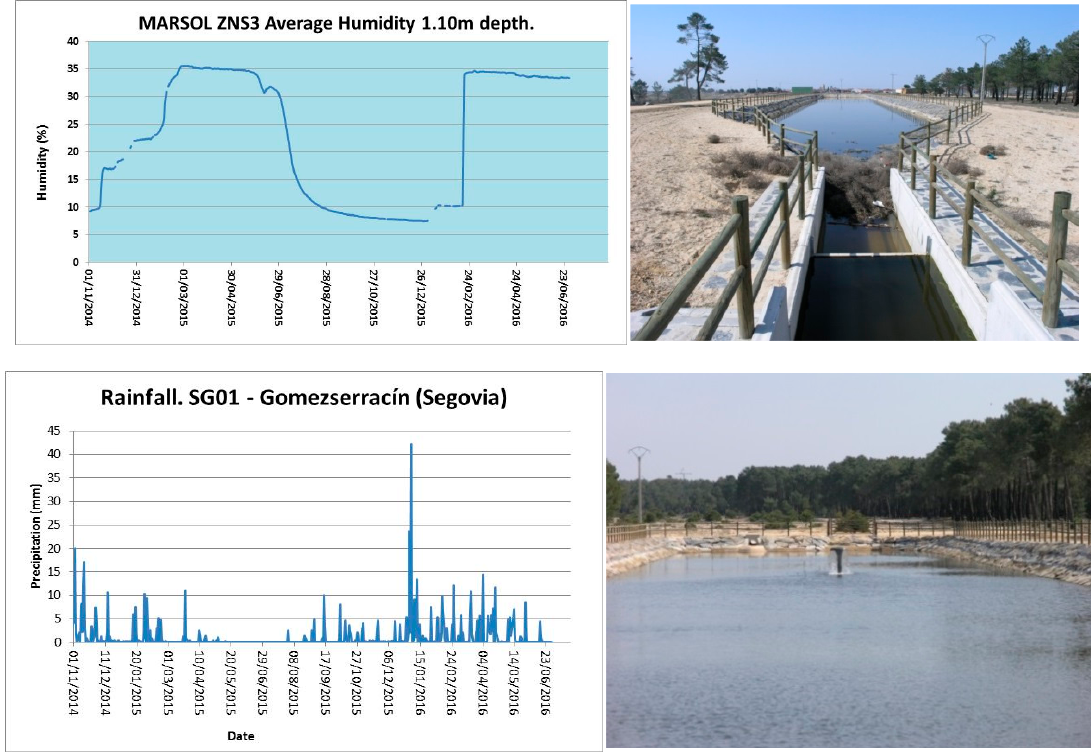
Figure 5. Infiltration ponds in the Los Arenales aquifer: Gomezserracín, soil humidity evolution from the so called MARSOL ZNS-3 station datasets (02/11/2014–30/06/2016) and natural precipitation evolution [9].